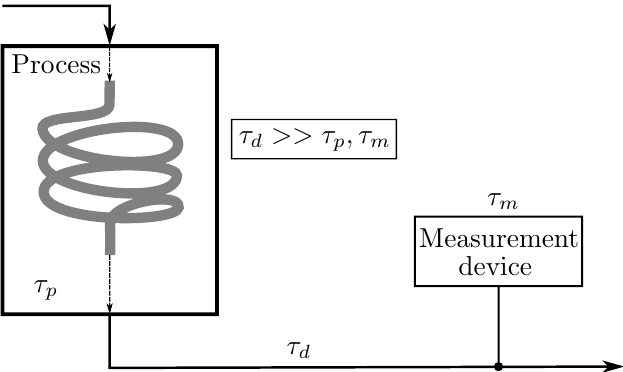
Figure 1. Illustration of a general process with a measurement device at a remote